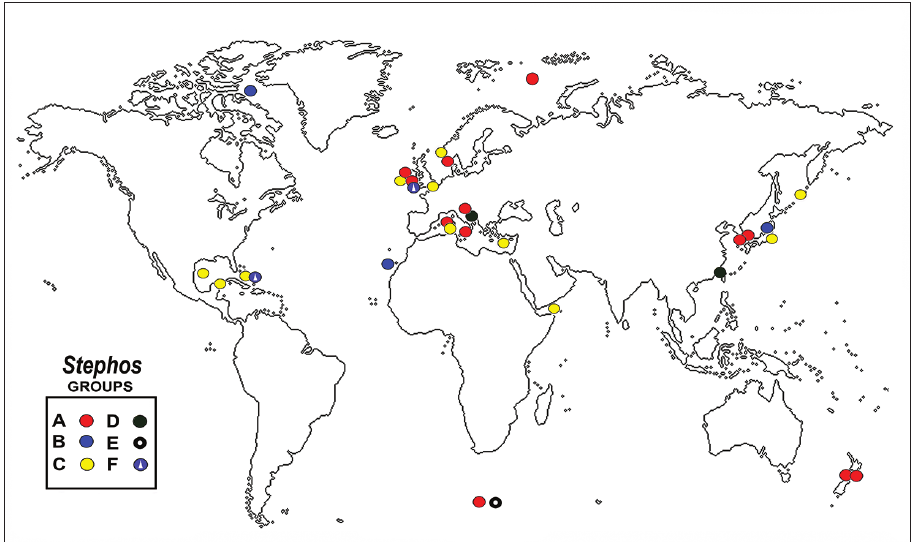
Figure 5. Geographic distribution of Stephos female fifth leg groups A–F . Group A lateral seta present, segment apically elongate B lateral seta present, segment not apically elongate, short C lateral seta absent, segment apically elongate D lateral seta present, segment elongate, with additional segmental processes, branched or bifurcate E lateral seta absent, segment elongate, with outer segmental processes F lateral seta absent, segment short, apically truncate or blunt, leg rami symmetrical or